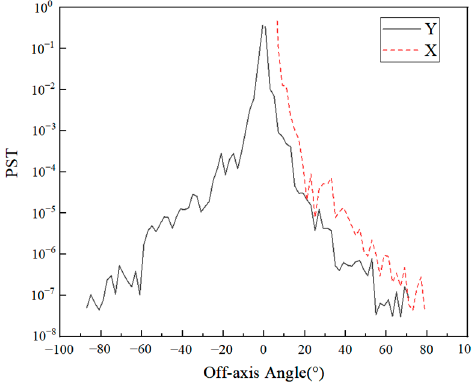
Figure 8. PST curves of the THz channel.